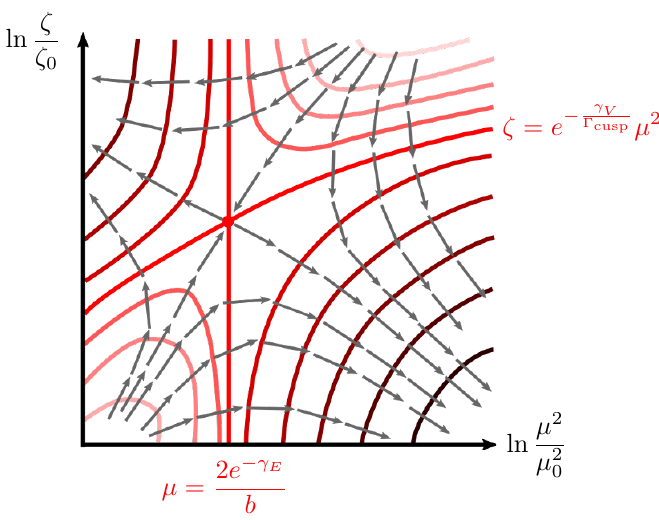
Figure 12 . Sketch of the geometry of the ( ζ, µ ) plane where the double scale evolution takes place. The anomalous dimensions determine a conservative field (grey arrows) and the evolution is null among equipotential lines (shades of red). The intersection of two special equipotential lines (bright red) determines a saddle point; the zeta-prescription corresponds to running the evolution from this point, after reinstating path invariance. The equations for the special equipotential lines in the figure correspond to the one-loop